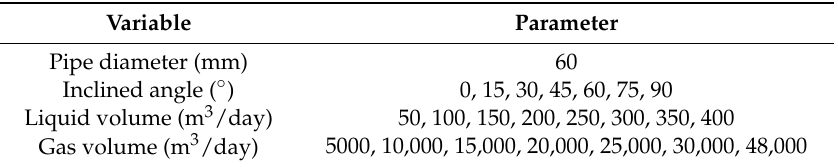
Table 2. Parameters of